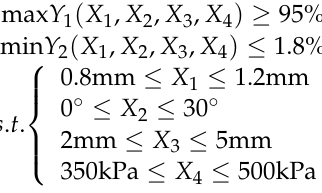
Table 3. Seeding effect of the TGOSM.